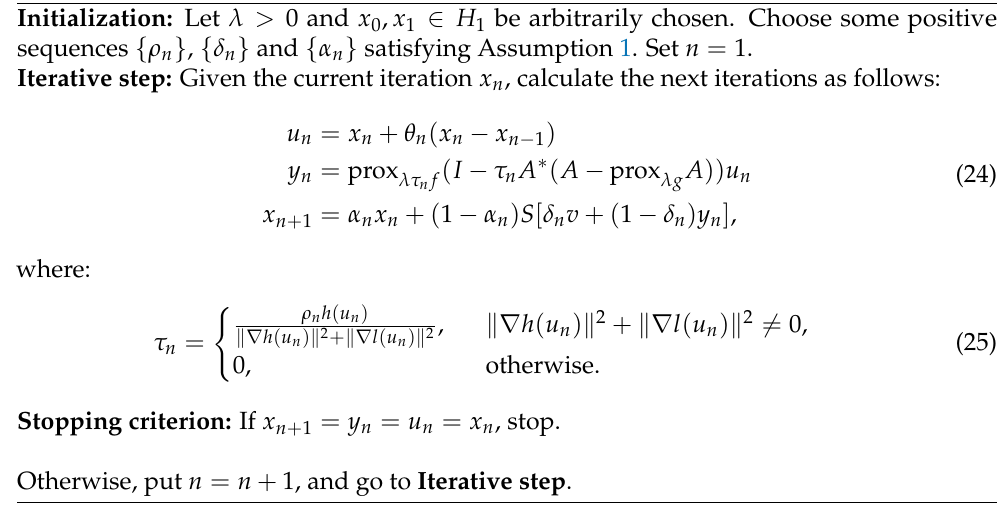
Algorithm 1 A split minimization